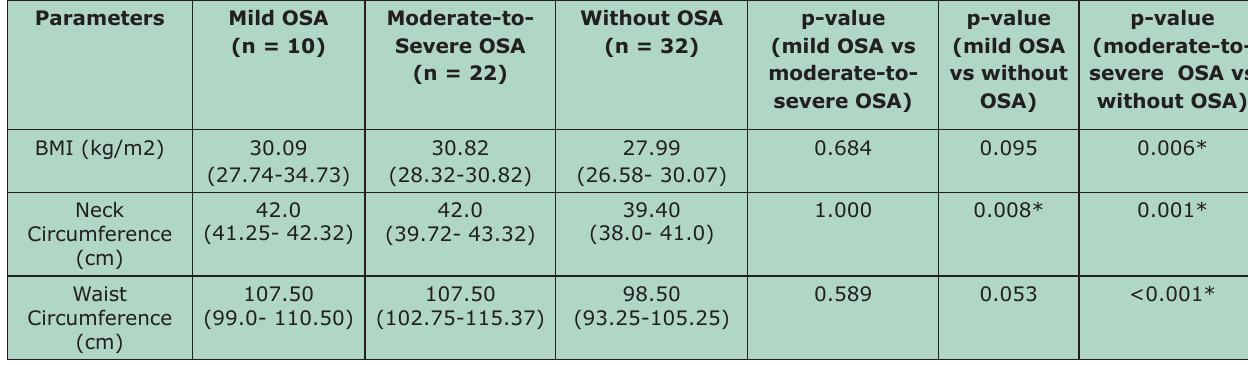
Table-II: Comparison of anthropometric parameters between mild OSA, moderate-to- severe OSA, and without OSA